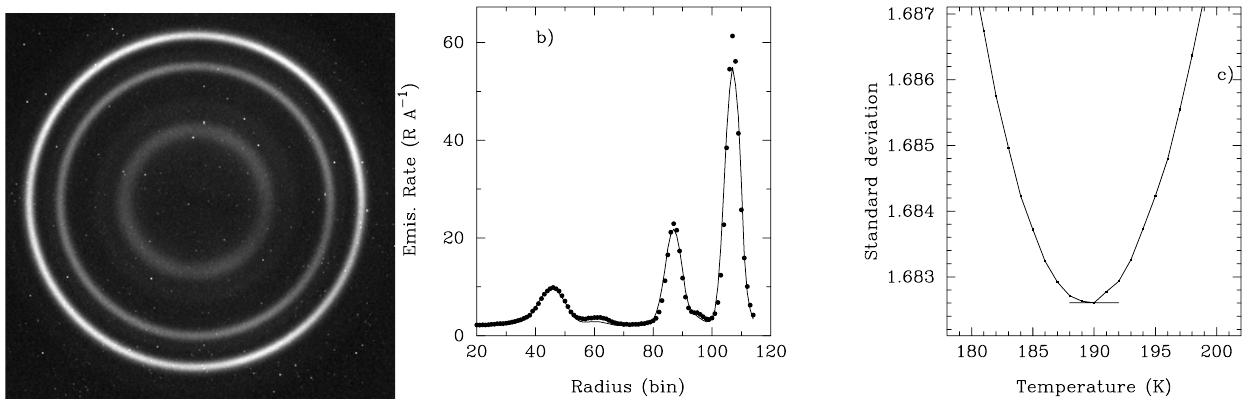
Fig. 1. (a) Typical OH SATI image. (b) Calculated (solid line) and observed (points) radial signal distribution for above OH image. Parameters are: A=920R, B=2.0RA − 1 , T=190 ◦ K . (c) Standard deviation of the fit versus